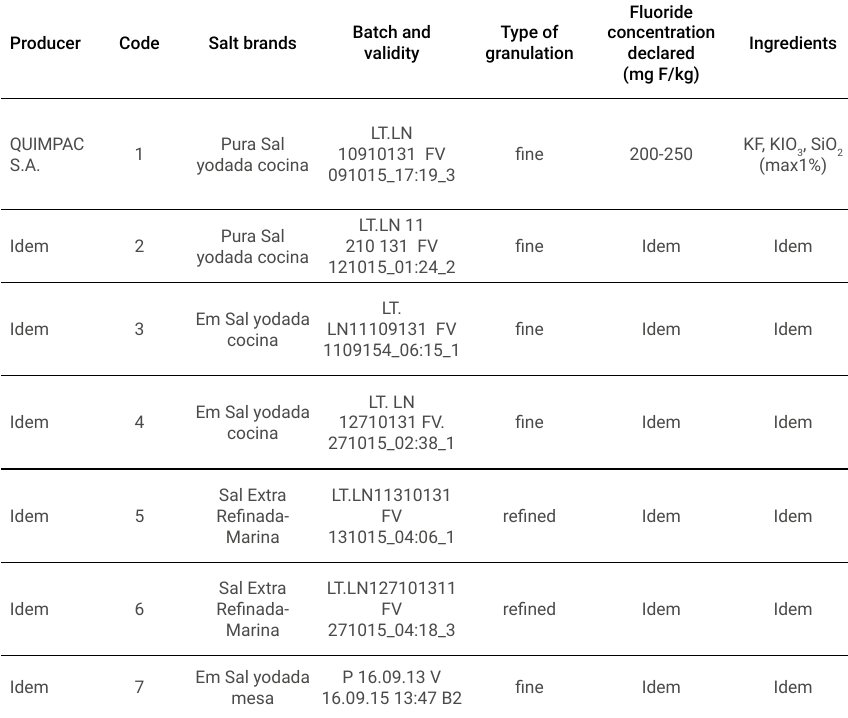
Table 1. Producer, code for analysis, salt brands, batch and validity, granulation type, fluoride concentration and ingredients declared on the label Producer Code Salt brands